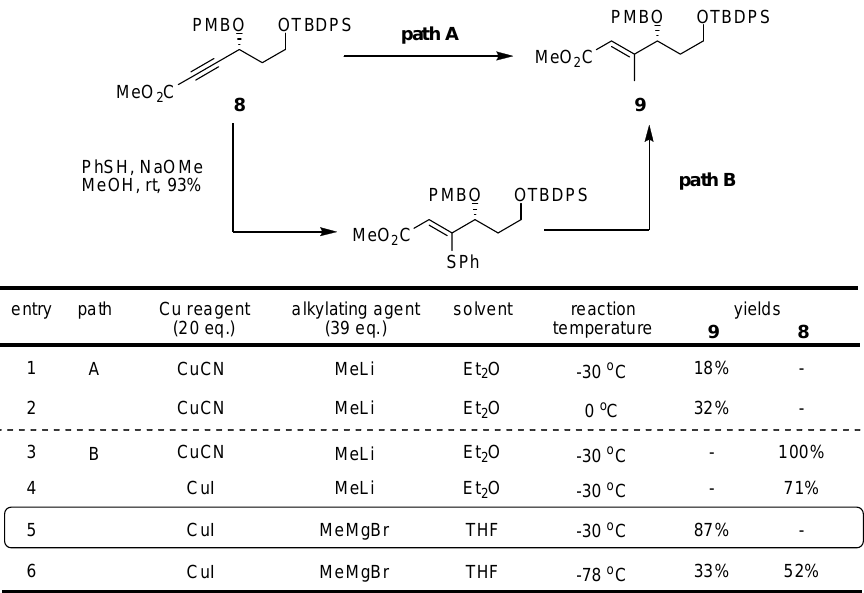
Table 1. 1,4-Addition of methyl group at C3 position of compound